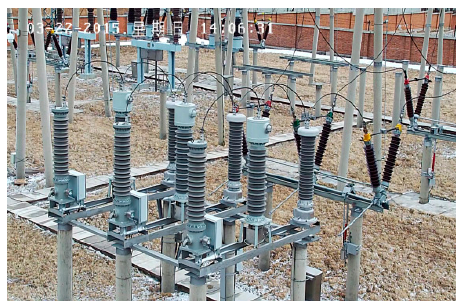
Figure 6. Site installation of the OVT.